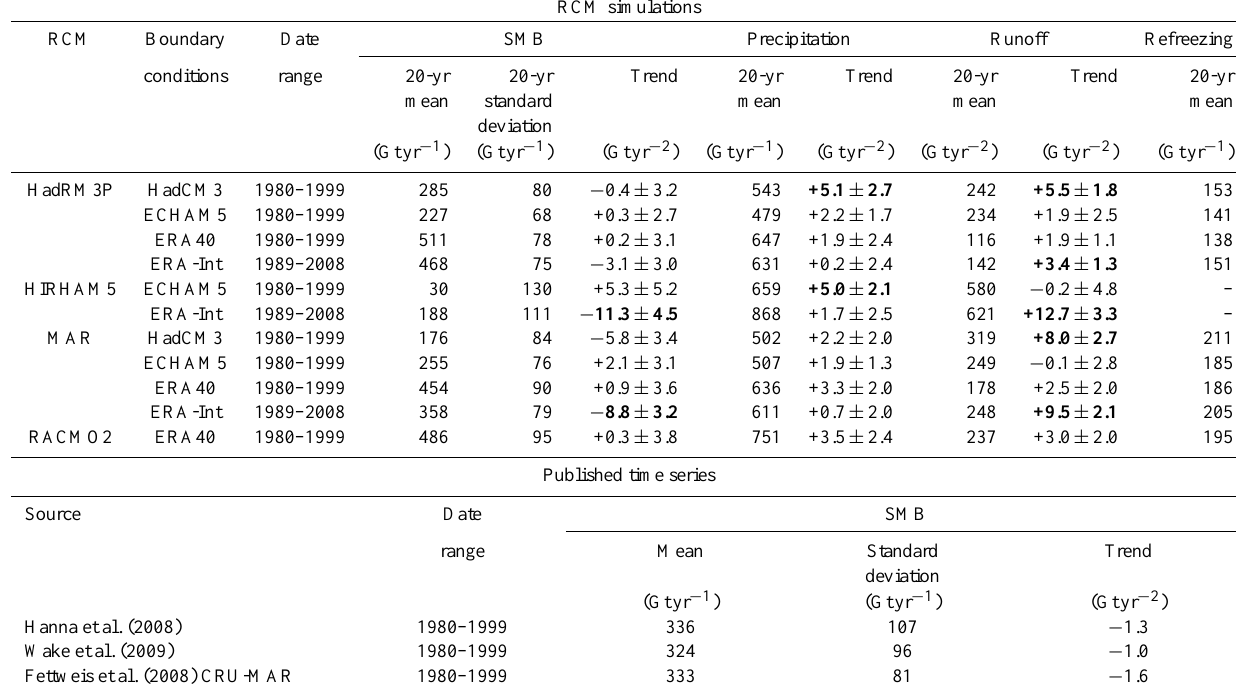
Table 5. Statistics for SMB and its components in simulations for the recent past. The values for the HadCM3-, ECHAM5- and ERA40- forced simulations are for 1980–1999; the ERA-Interim-forced simulations are for 1989–2008. Precipitation is total (solid+liquid). Trends which are significantly different from zero at the 2 σ level are highlighted in bold. Results are also shown for previously-published time series.